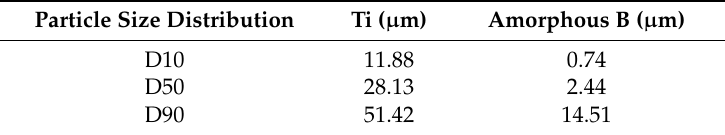
Table 1. Particle size distributions of the starting powders.